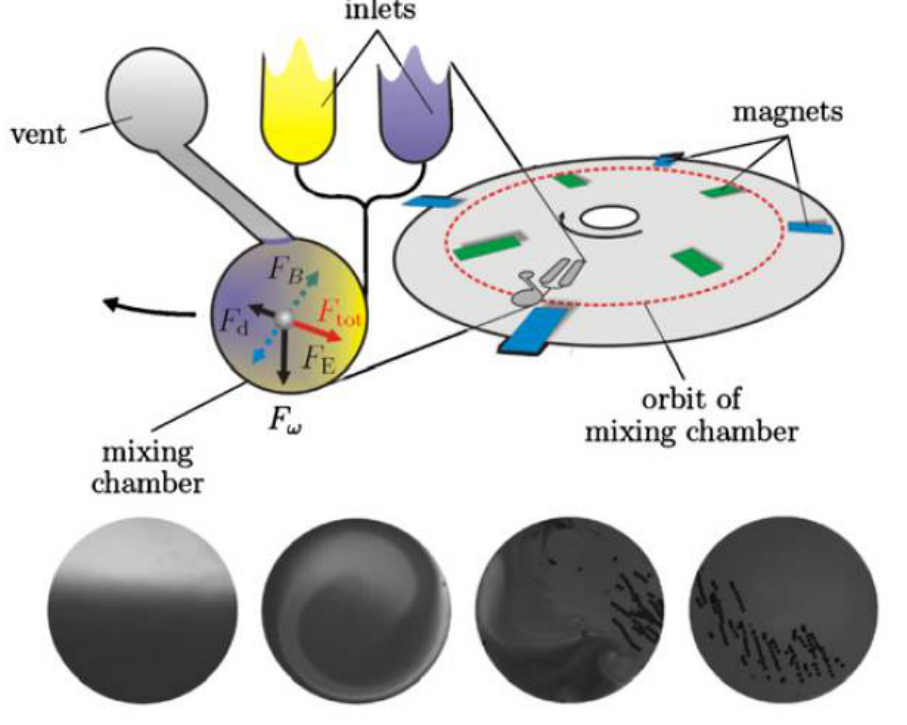
Figure 3. Illustration of rapid mixing techniques in centrifugal microfluidic systems based on the work by Grumman et al. [47], where magnets are used to facilitate mixing. Permanent magnets are aligned on the set-up at radial positions that are inbound and outbound relative to the mean orbit (dashed circle) of the rotating mixing chamber. A magnetic bead inside the mixing chamber is thus exposed to an alternating radial force F B and a viscous drag force F d , in addition to the centrifugal force F ω and Euler force F E . The bottom row of images shows the flow patterns within the mixing chamber. Image reproduced from [46]. © IOP Publishing. Reproduced with permission. All rights